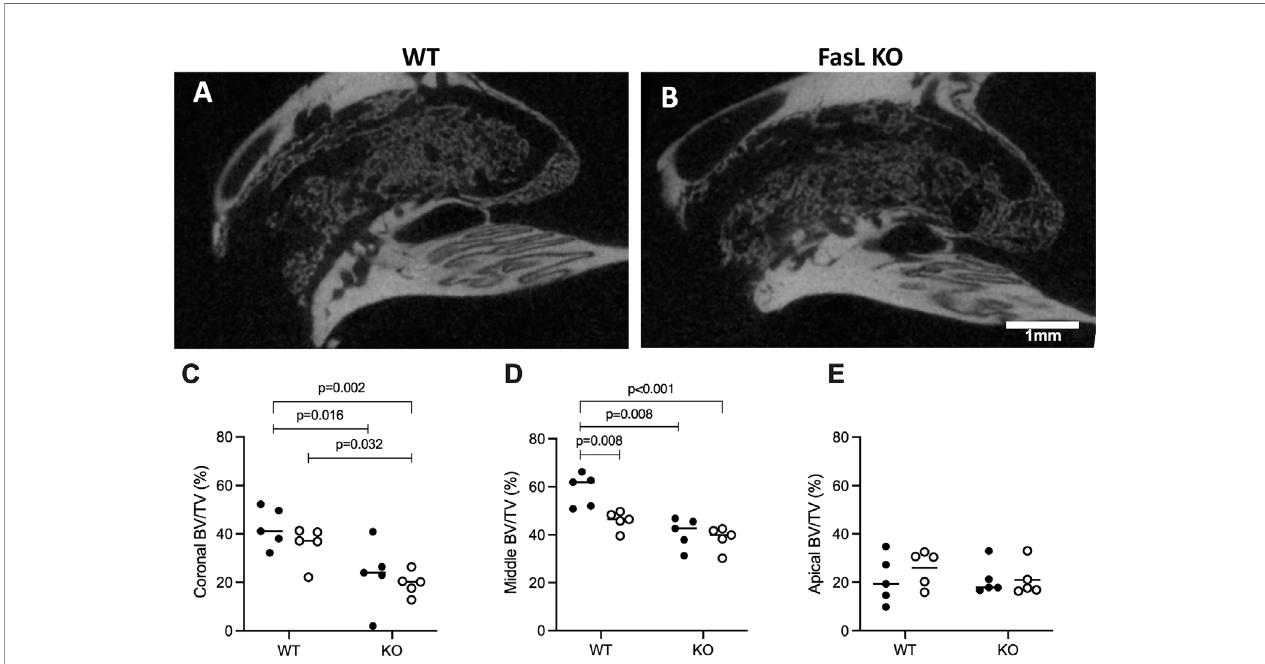
FIGURE 2 | Lack of FasL attenuates regeneration of the extraction socket. Sagittal view of the alveolar socket depicts the WT (A) and FasL KO mice (B) . Quantitative analysis of the bone volume per tissue volume (BV/TV) displayed higher amounts of new bone volume in the WT mice in the coronal (C) and middle part (D) of the extraction socket compared to FasL KO mice. The apical region revealed no signi fi cant differences in BV/TV between WT and FasL KO mice (E) . Statistical analysis was based on Mann ‐ Whitney U test, P values are given where there was signi fi cant differences. The bars show the median and female (black dots) and male mice (white dots) are distributed in the dot plots for the WT and KO